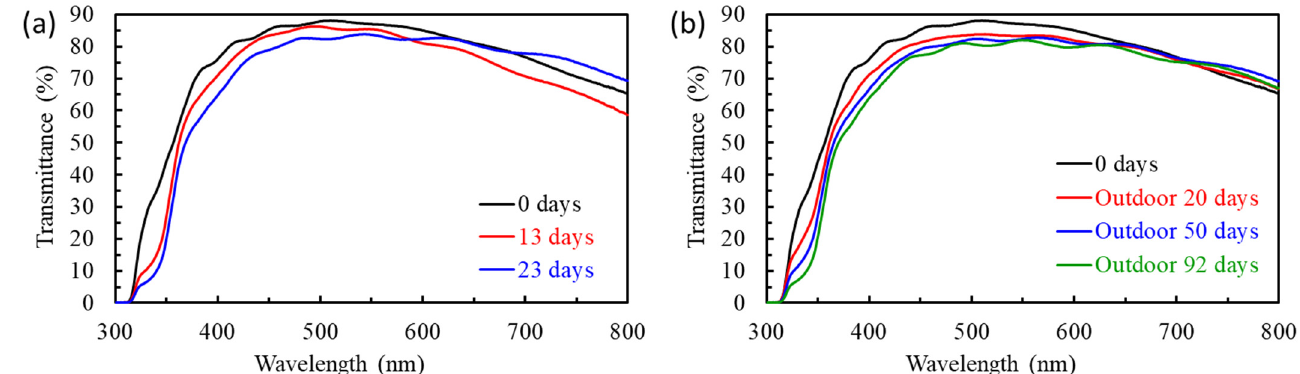
Figure 5. UV–Vis spectra showing the optical transmittance of the OMO samples before and after ( a ) indoor accelerated and ( b ) outdoor weathering tests.